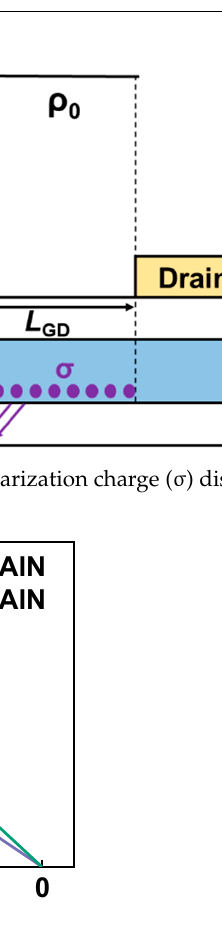
Figure 9. Additional polarization charge ( σ ) versus V GS with 8 nm and 5 nm InAlN barrier.